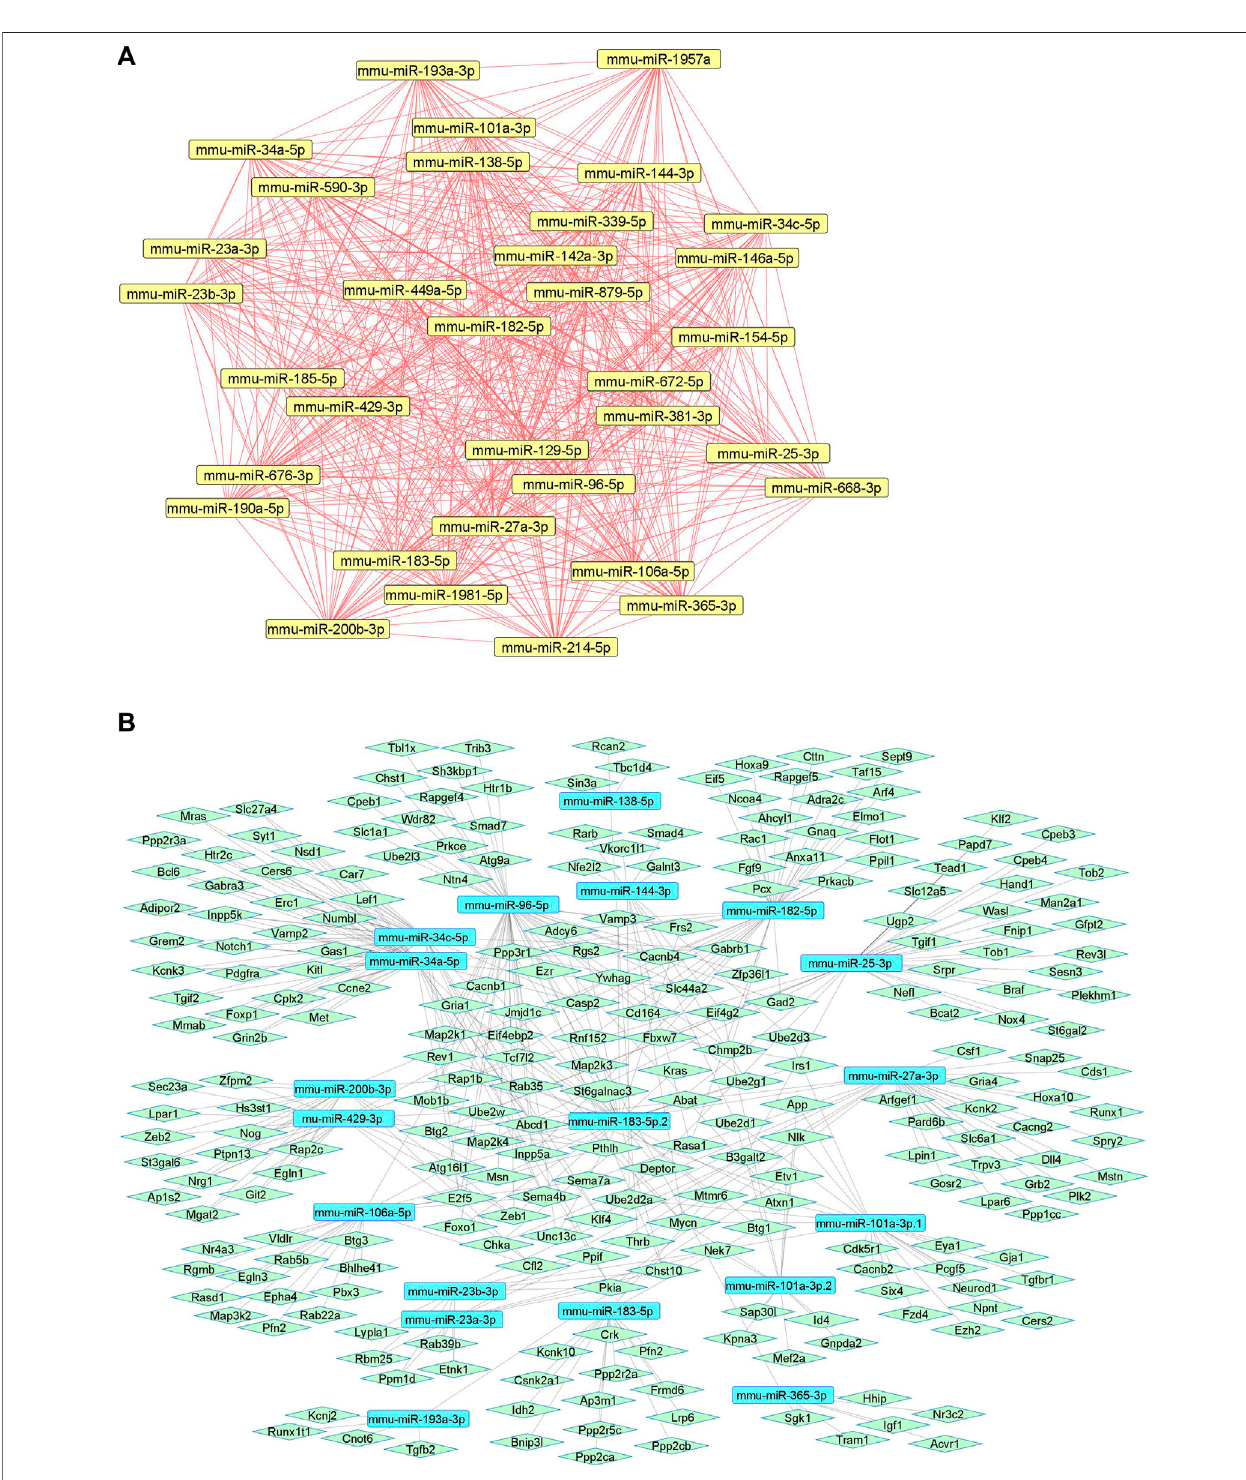
FIGURE 5 | Downregulated mouse microRNA networks in neuropathic pain: (A) Mouse microRNA – microRNA network: Mouse miRNA-miRNA interaction networkwith34nodesand561edges.ThenetworkswereconstructedusingCytoscape3.8.2. (B) MousemicroRNA – genetargetnetwork:Architectureofnetworksof upregulated miRNAs in mouse implicated in neuropathic pain showing interaction network of functionally enriched miRNAs with their targets with 275 nodes and 413 edges.ThenetworkswereconstructedusingCytoscape3.8.2.UsingMienturnet,themiRNA-targetinteractionswereidenti fi edbyTargetScanandthefunctionally enriched miRNAs were generated using the KEGG